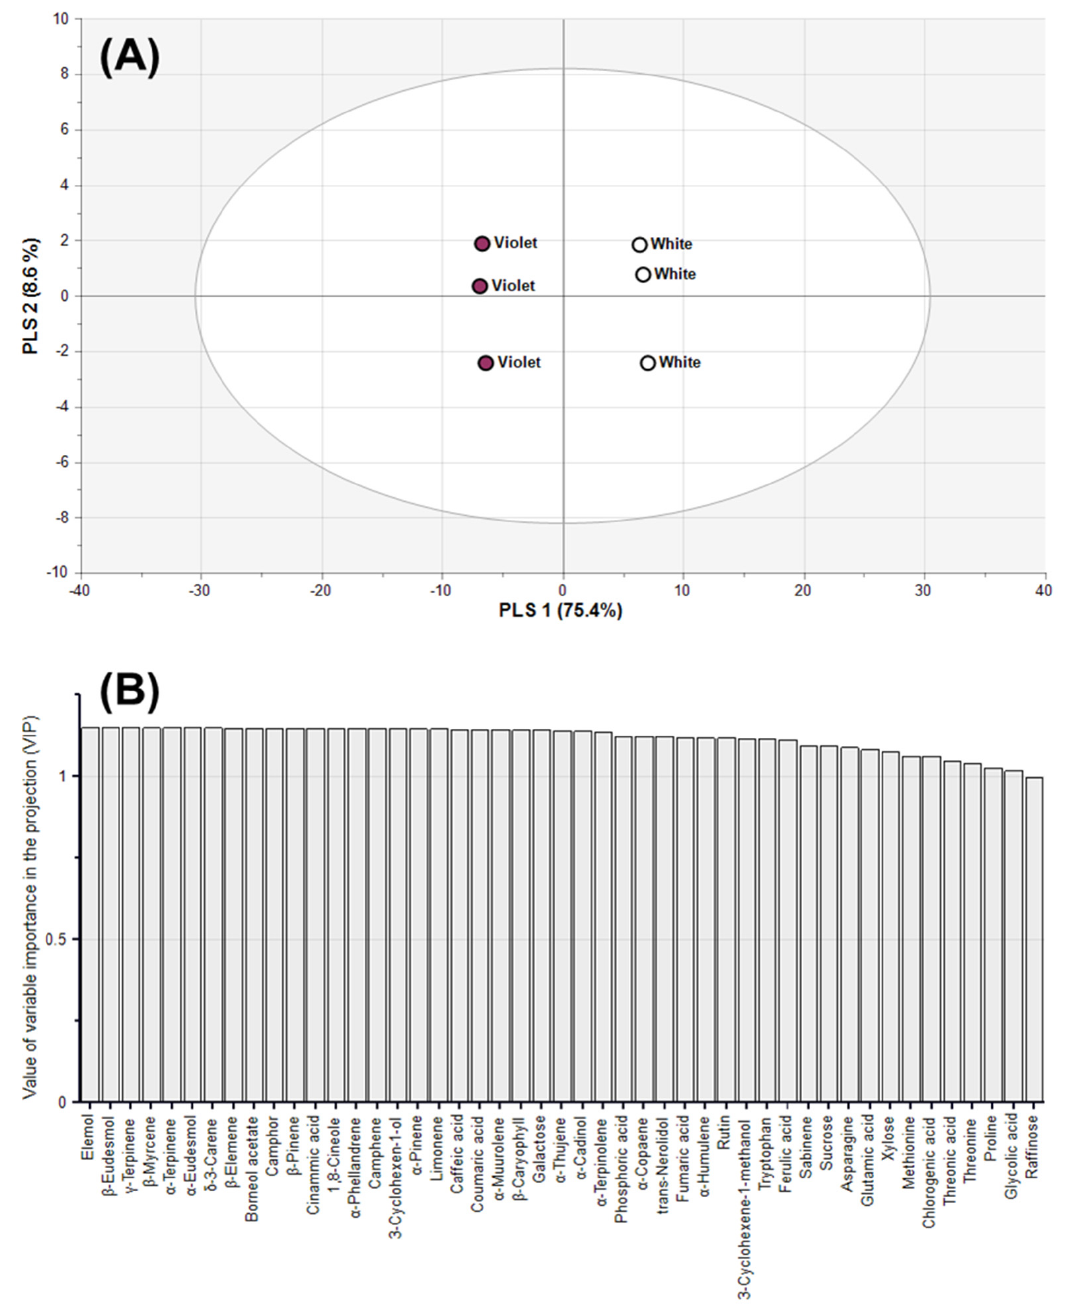
Figure 3. Partial least squares discriminant analysis (PLS-DA) score plots ( A ) and variable importance in projection (VIP) scores above 1.0 ( B ) for M. heptapeta (white) and M. denudata var. purpurascens (violet) flower buds.